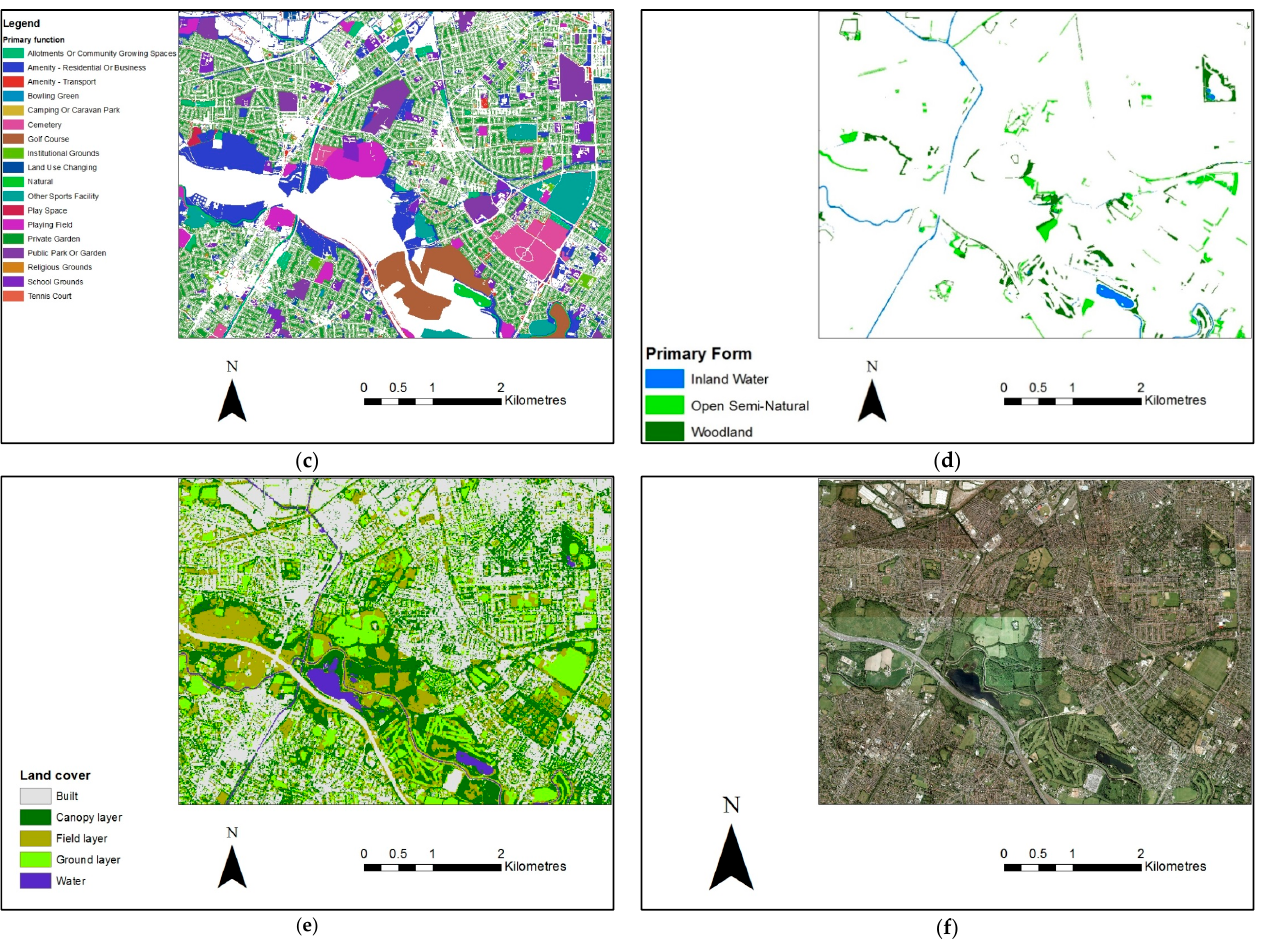
Figure 7. ( a ) (Top left) UK LCM 2015 (Rowland et al., 2017); ( b ) (top right) Urban Atlas 2012 (EEA, 2012); ( c ) (centre left) OS Mastermap Greenspace: land use (Ordnance Survey, 2017); ( d ) (centre right) OS Mastermap Greenspace: land cover (Ordnance Survey, 2017); ( e ) (bottom left) composite land cover map from stage one of the method and ( f ) aerial photograph (25 cm) of the same area (Edina,